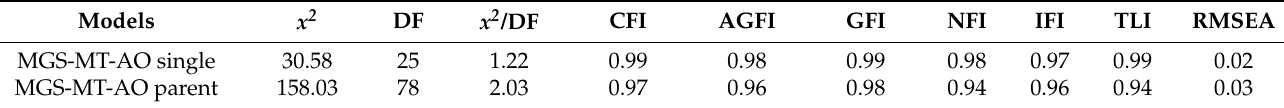
Table 2. Confirmatory Factor Analysis; MGS, AO, and MT, Measurement Model.